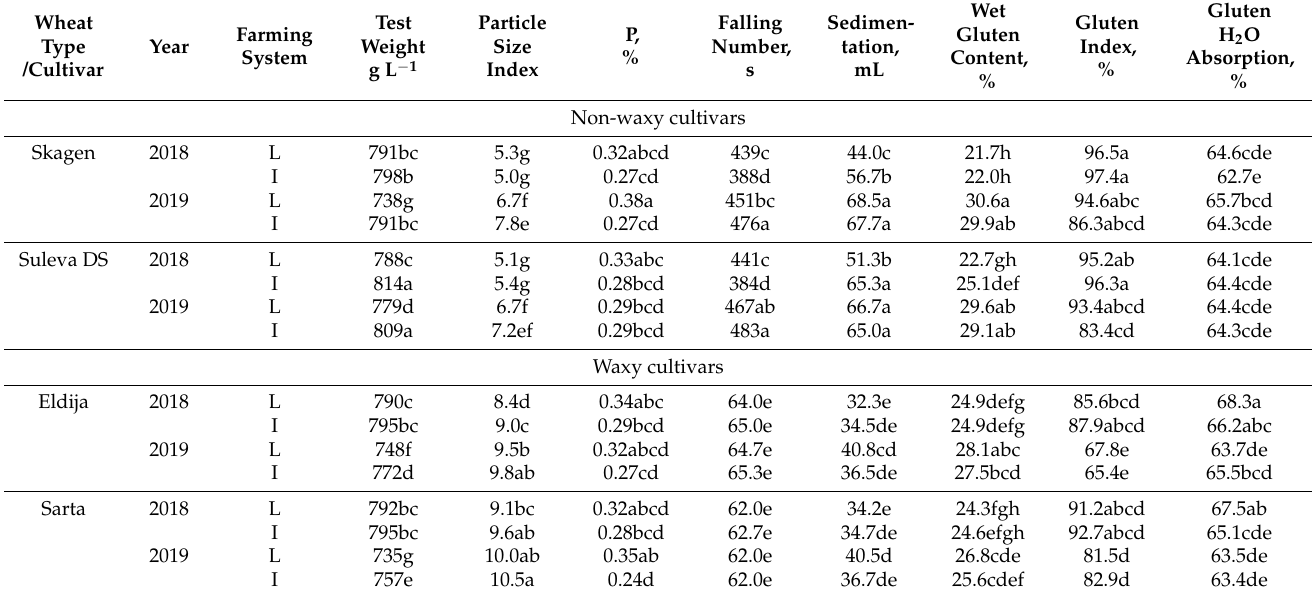
Table 1. Grain chemical composition and quality characteristics of non-waxy and waxy winter wheat cultivars grown under different farming systems in two cropping